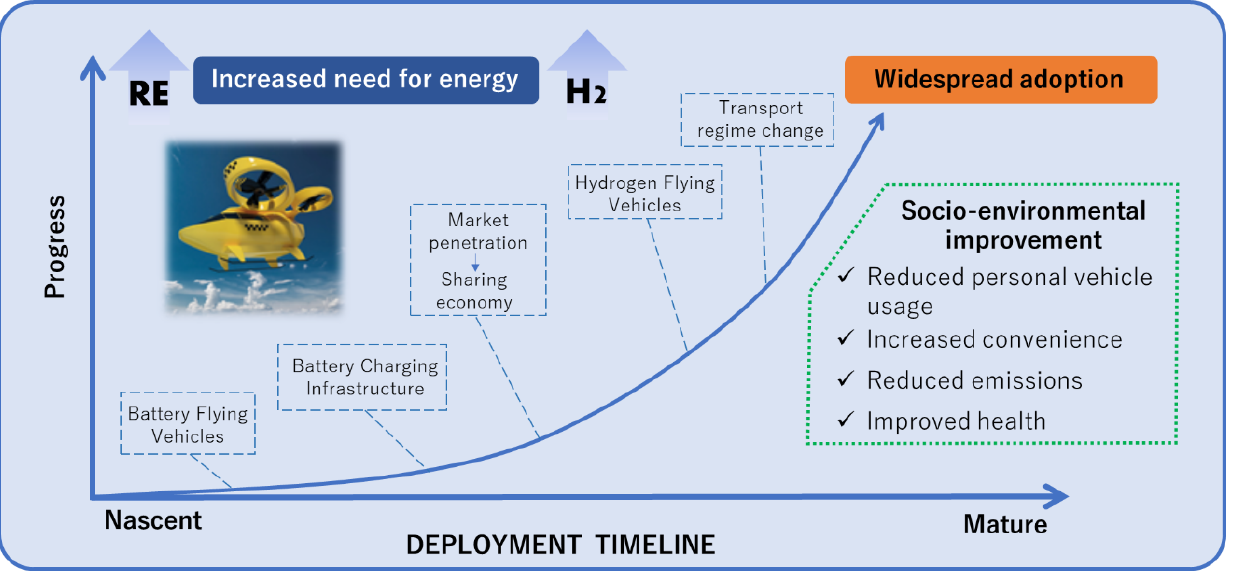
Figure 2. Potential Flying Vehicle Deployment Timeline and Envisaged Socio-Environmental Improvements .